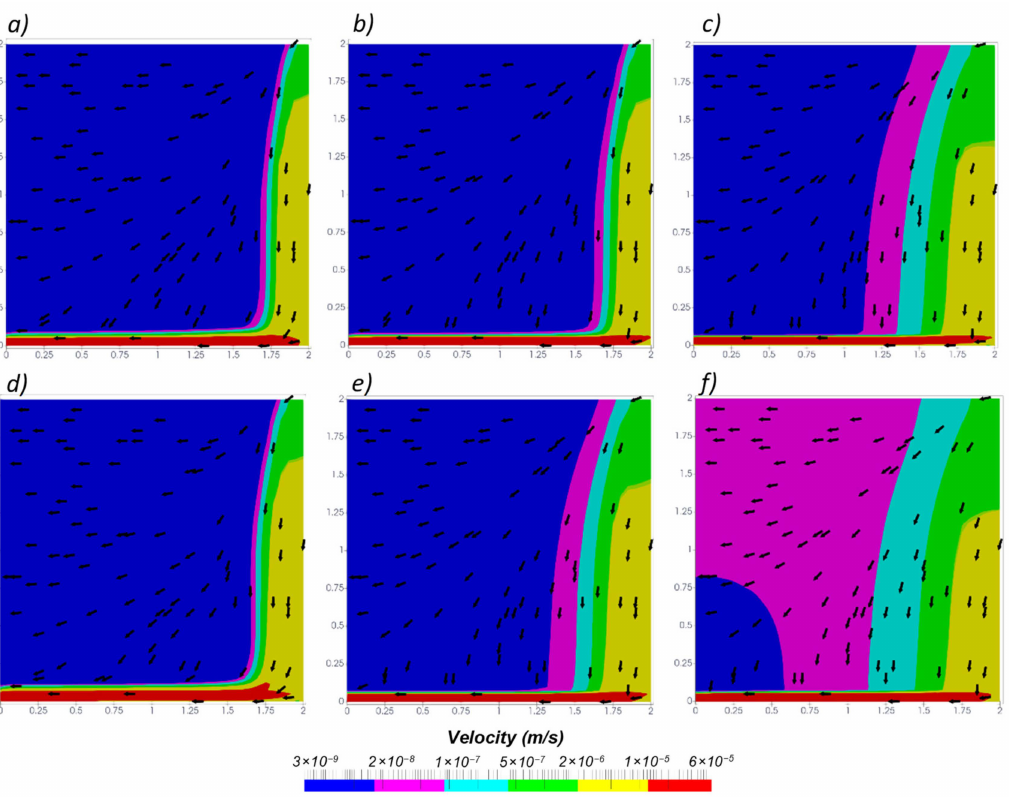
Figure 16. Spatial distribution of the computed direction and modulus of the flow velocity after 500 years of simulation in scenario 1 by using the following permeability-porosity relationships: ( a ) Kozeny-Carman; ( b ) modified Fair-Hatch; ( c ) Verma-Pruess; ( d ) power law with n = 5; ( e ) power law with n = 3; ( f ) power law with n =